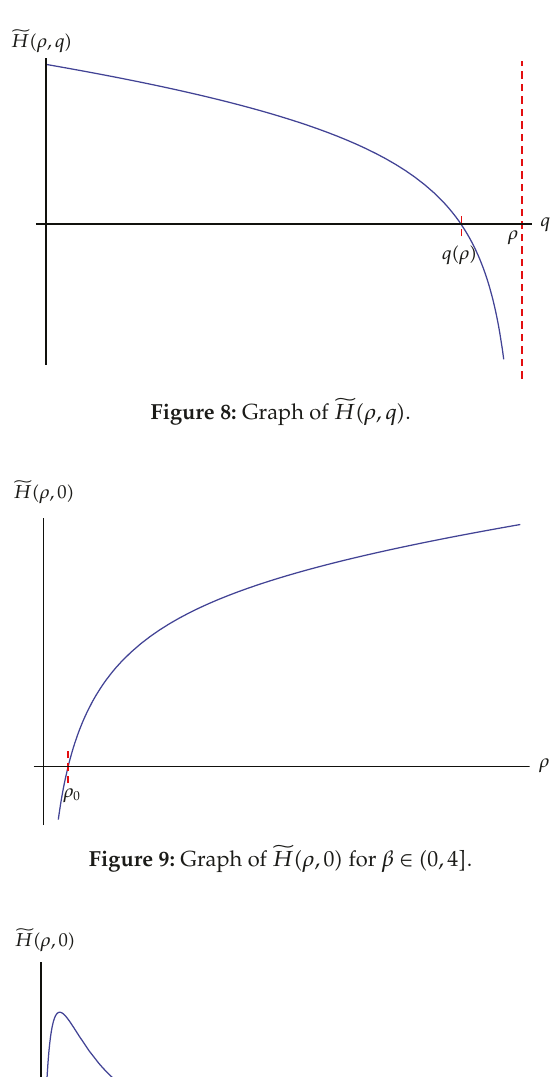
(cid:22) Figure 10: H (cid:4) ρ, 0 (cid:5) for β ∈ (cid:4) 4 , ∞ (cid:5)